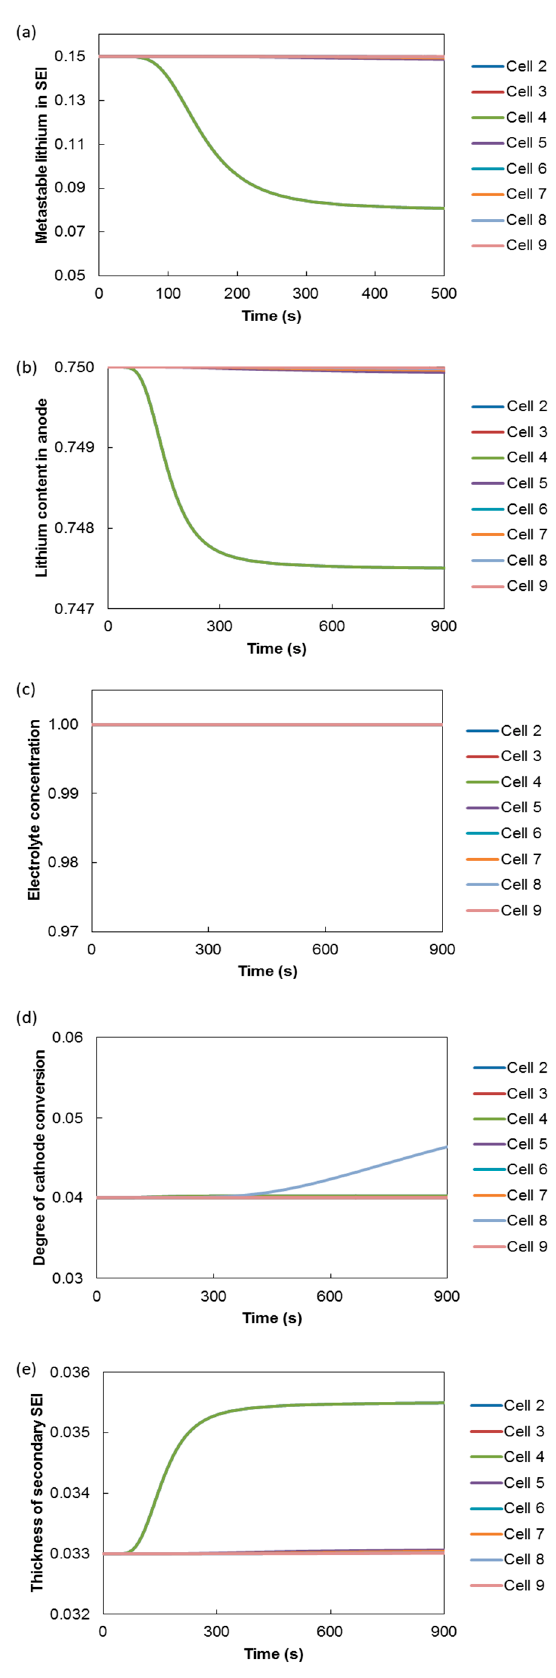
Figure 15. The progress of reaction ( a ) SEI ( b ) anode ( c ) electrolyte ( d ) cathode and ( e ) secondary SEI thickness, in all other cells in the battery module.